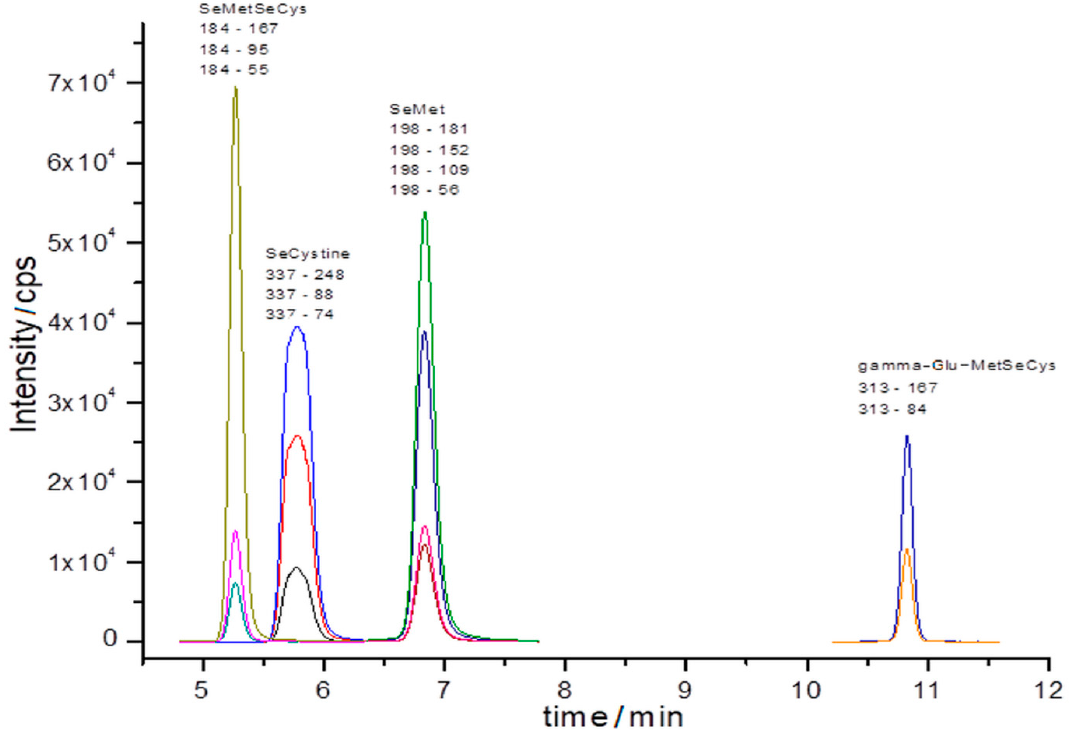
Figure 3. MRM chromatogram registered for standards solution (transitions precursor ion → product ion) of 250 µg/L of each compound: SeMetSeCys, SeCys, SeMet, and gamma-Glu-MetSeCys. Chromatograms registered for extracts from sprouts are presented in Figure 4a, 4b, and 4c and respectively.